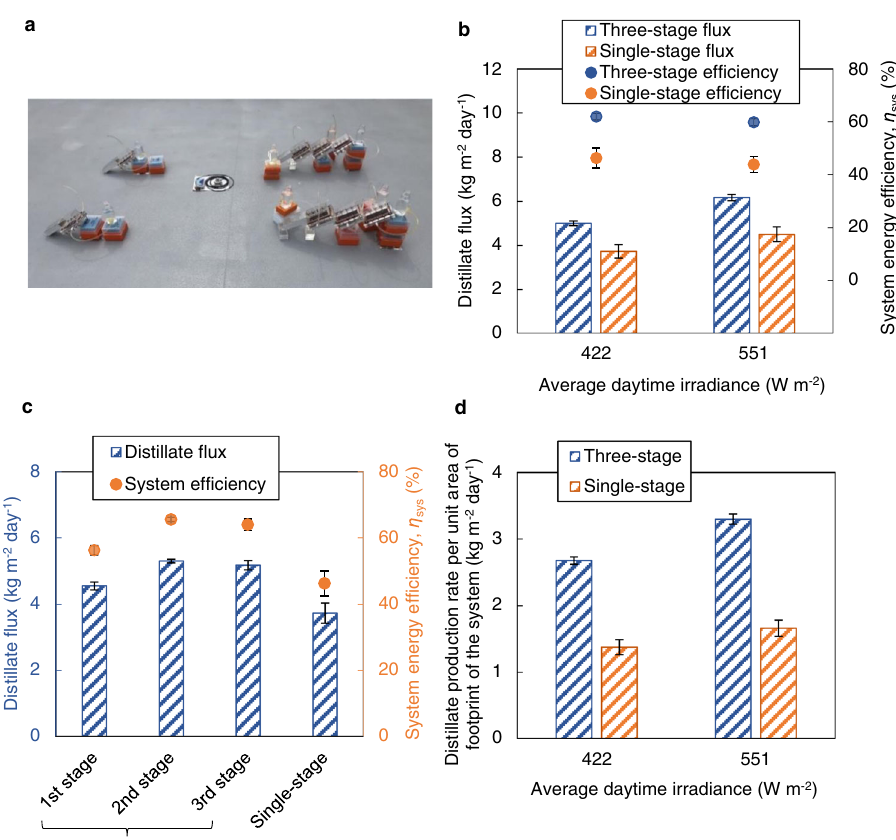
Fig. 6 The performance of three-stage planar systems under natural sunlight. a The photograph of three-stage and single-stage planar systems [membrane dimensions: 120 mm (L) × 50 mm (W)] placed under natural sunlight at 30° inclination with respect to the horizontal. b Distillate fl uxes and system energy ef fi ciencies of three-stage systems compared with that of single-stage planar systems under natural sunlight in August, 2021. The single-stage systems had the same dimensions as each stage in the three-stage systems. c Distillate fl uxes and ef fi ciencies in each stage of the three-stage systems, and the single-stage planar systems at an average daytime irradiance of 422 W m − 2 . d Distillate production rate of the single-stage and three-stage planar systems under natural sunlight per unit area of footprint. The surface density of carbon black NPs on the permeate side of membrane was 7.1 ‒ 8.0 g m − 2 and the hydrostatic pressure at the center of the membrane was 95 ‒ 105 mmH 2 O (0.93 ‒ 1.03 kPa), for both systems, as shown in Supplementary Table 5. In these experiments, DI water was used as feedwater and feedwater temperature was between 22.5 and 33 °C. Variation of irradiance and weather condition can be found in Supplementary Table 4. The error bars represent the standard deviations of duplicate results obtained using two different systems on the same